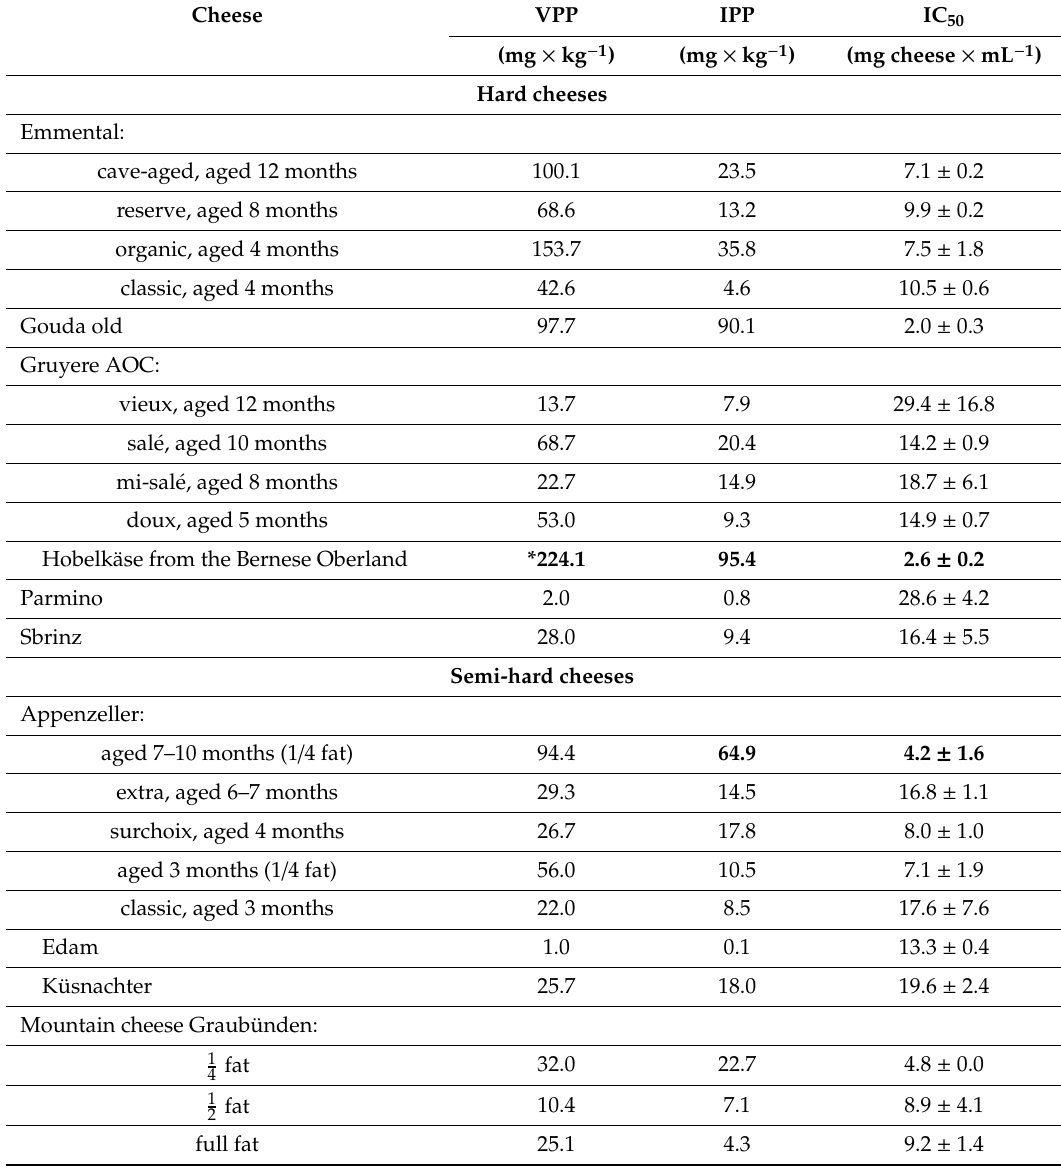
Table 1. Quantification of VPP and IPP in cheeses of Swiss origin with their corresponding ACE inhibitory activity expressed with IC 50 values. Adapted with permission from [29], Copyright Elsevier,